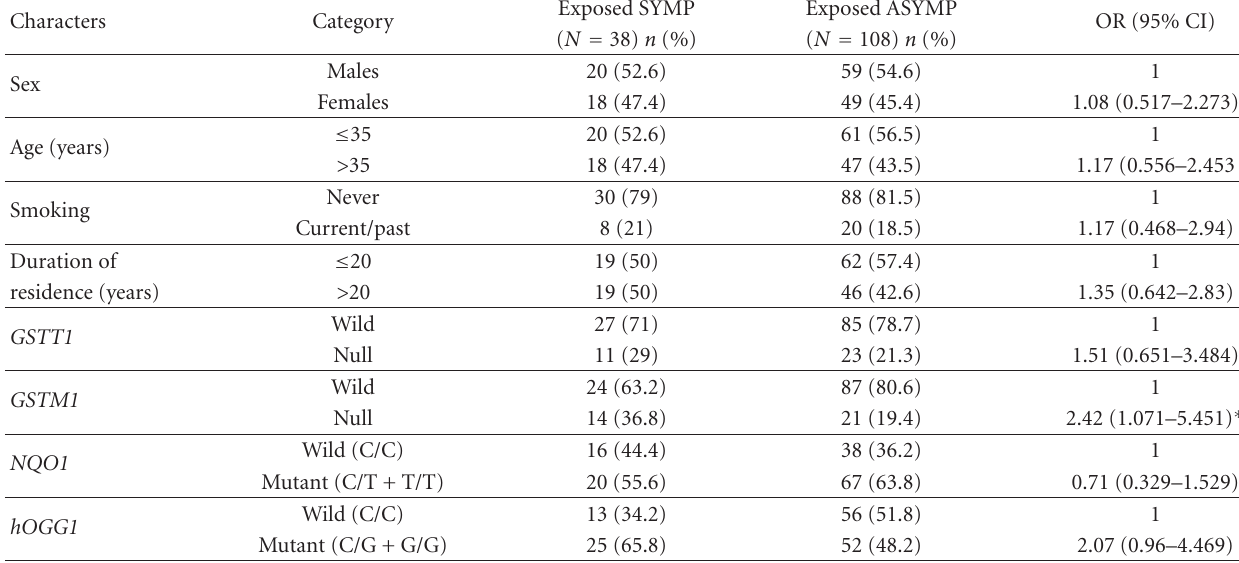
Table 5: Influence of various covariates and genotypes on dermatological adversities among symptomatic exposed compared with asymptomatic exposed